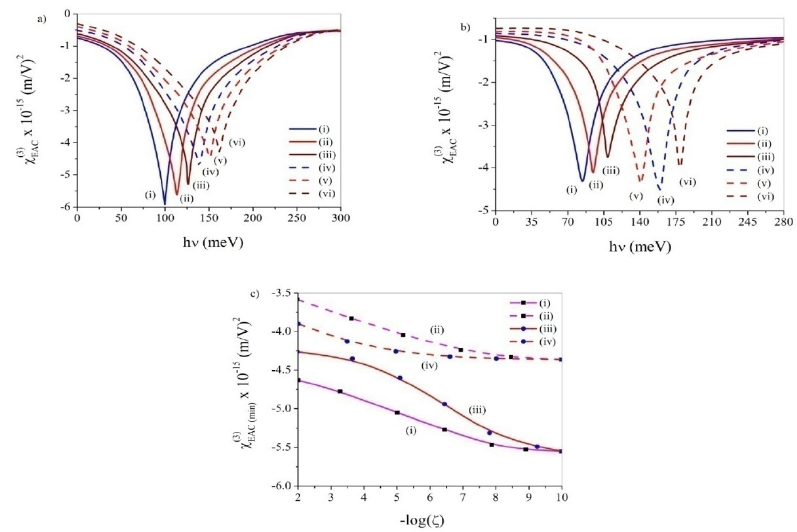
Figure 12. EAC vs. h υ diagrams with ( a ) OPA and ( b ) EPA. In these diagrams (i) ADWN and ζ = 10 − 10 , (ii) ADWN and ζ = 10 − 6 , (iii) ADWN and ζ = 10 − 2 , (iv) MLWN and ζ = 10 − 10 , (v) MLWN and ζ = 10 − 6 , (vi) MLWN and ζ = 10 − 2 . ( c ) Depiction of EAC peak minima vs. − log( ζ ): (i) with ADWN and OPA, (ii) with ADWN and EPA, (iii) with MLWN and OPA and (iv) with MLWN and EPA. With even anharmonic potential and under applied ADWN the EAC peak displays blue-shift regular fall of the peak altitude (in absolute sense) as ζ enhances. Under applied MLWN the change of EAC peak height shows the same trend as mentioned above. How- ever, the peak shift becomes non-uniform. The EAC peaks now initially exhibit red-shift up to ζ ~10 − 6 followed by blue-shift as ζ is increased beyond. Figure 12c delineates the profiles of EAC minimum peak values against ζ under ap- plied ADWN and MLWN, both with OPA and EPA. In these profiles the value of anhar- monicity constant was fixed at k = 10 − 4 . The plots evince persistent decline in the EAC peak value (in absolute sense) with an increase in the noise strength under all conditions. 3.7. DC-Kerr Effect (DCKE) DCKE is an acclaimed phenomenon to probe photoemission and the detection appli- cations of QDs [46–54]. The structural variation of QD often makes it feasible to harness and even maximize the magnitude and resonance wavelength of DCKE [46]. Amplified DCKE with diminished linear and nonlinear absorption possesses huge usage in several quantum devices as it makes NLO studies quite significant at reduced light power [52,53]. This, in turn, indicates that the linear susceptibility needs to be diminished as low as pos- sible for all pump and signal fields to minimize the absorption [52]. The real part of χ (3) (see Equation (20)) is called the DCKE and is given by [46]: 𝜒 (cid:3005)(cid:3004)(cid:3012)(cid:3006)((cid:2871)) (𝜈) = 𝑅𝑒(cid:3427)𝜒 ((cid:2871)) (−𝜈,0,0,𝜈)(cid:3431)